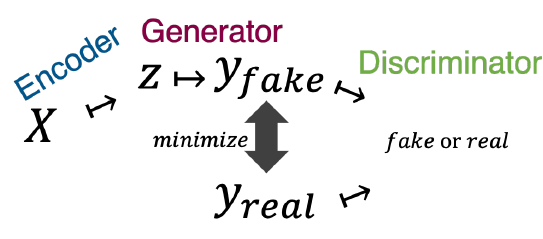
Figure 1. Aerial photo to point clouds translation pipeline using conditional adversarial generative